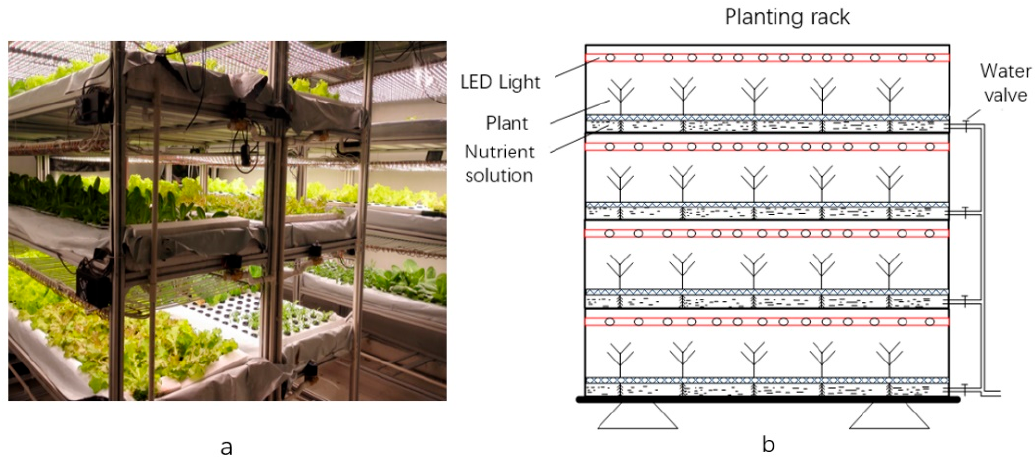
Figure1. Plantfactory. ( a )showstheplantfactorylaboratory; ( b Figure 1. Plant factory. ( a ) shows the plant factory laboratory; ( b ) is the model of the plant factory laboratory.